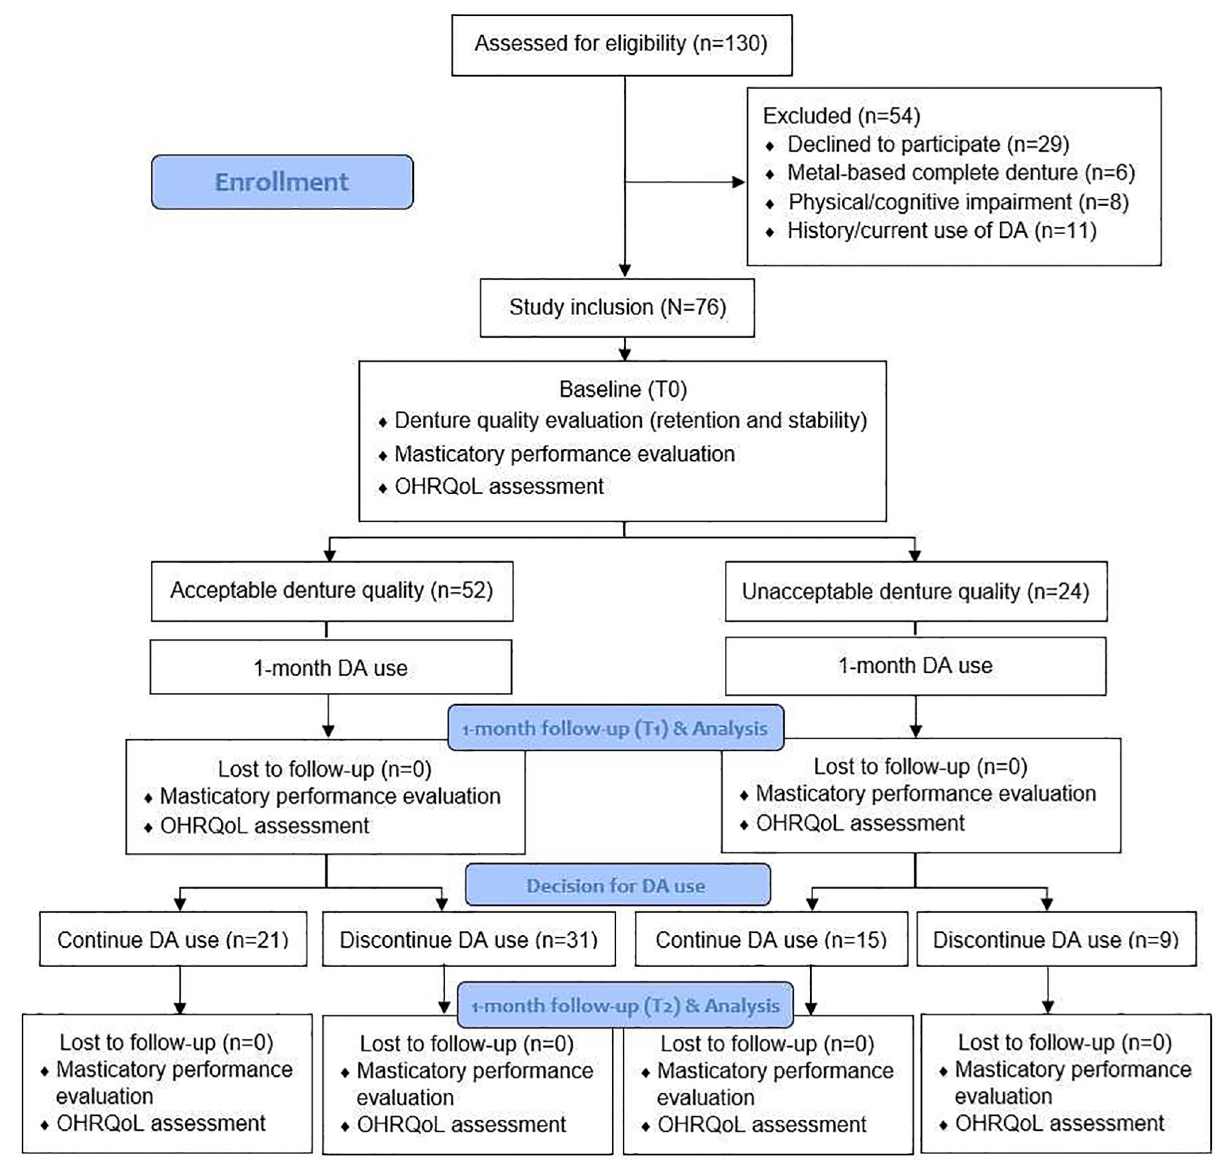
Fig 1. Flow diagram of the study (adopted from CONSORT